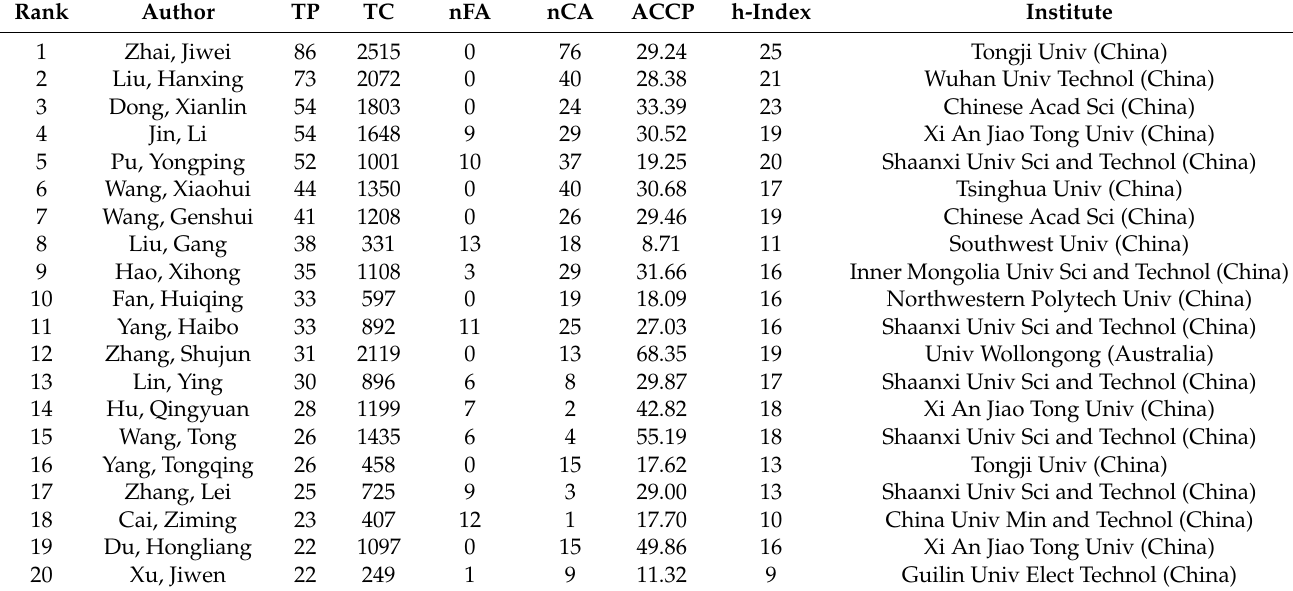
Table 3. Contribution of the top 20 authors in energy storage ceramics